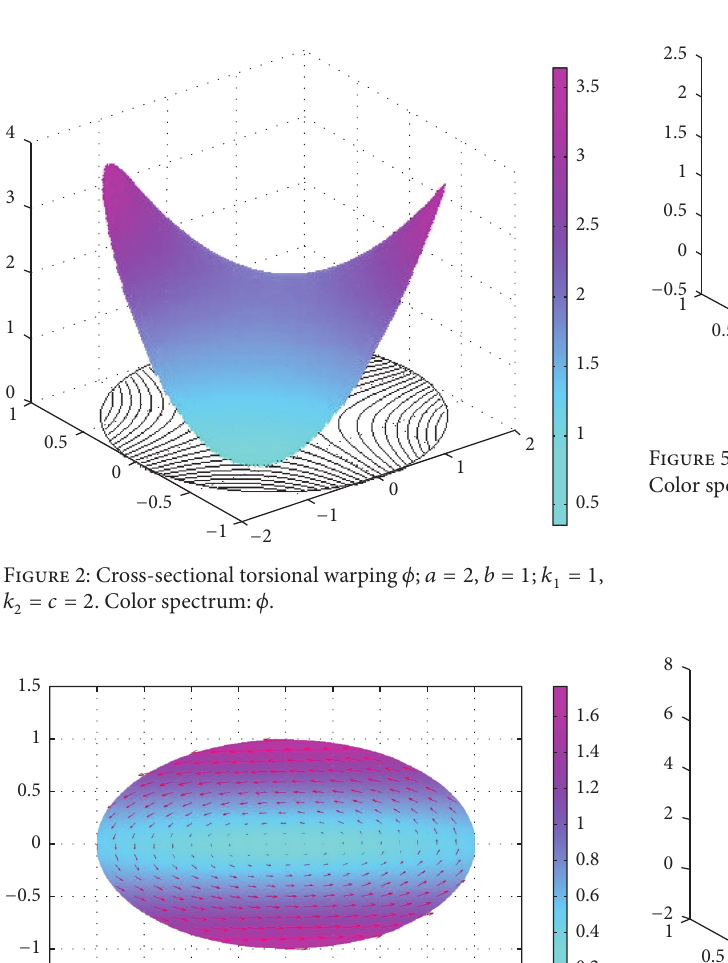
Figure 1: Shear modulus 𝜇 𝑥 ; 𝑎 = 2 , 𝑏 = 1 ; 𝑘 1 = 𝑘 3 = 1 , 𝑘 2 = 2 . Color spectrum: 𝜇 𝑥 .